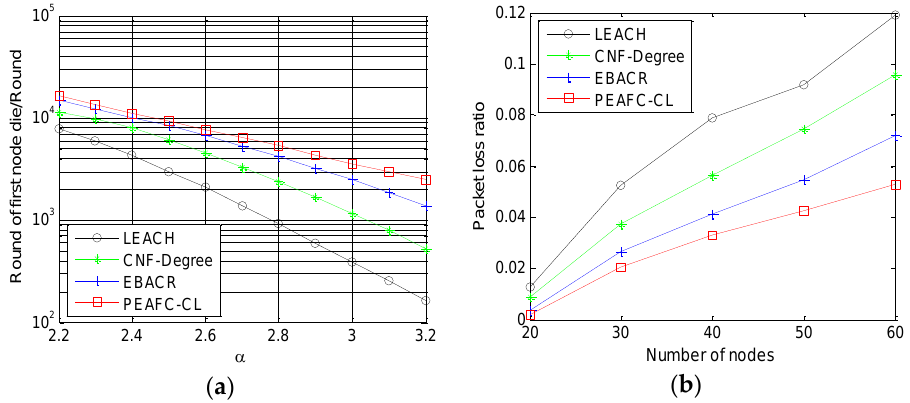
Figure 11. ( a ) Round when the first node dies vs. α ; ( b ) Packet loss ratio vs. number of nodes for different protocols.